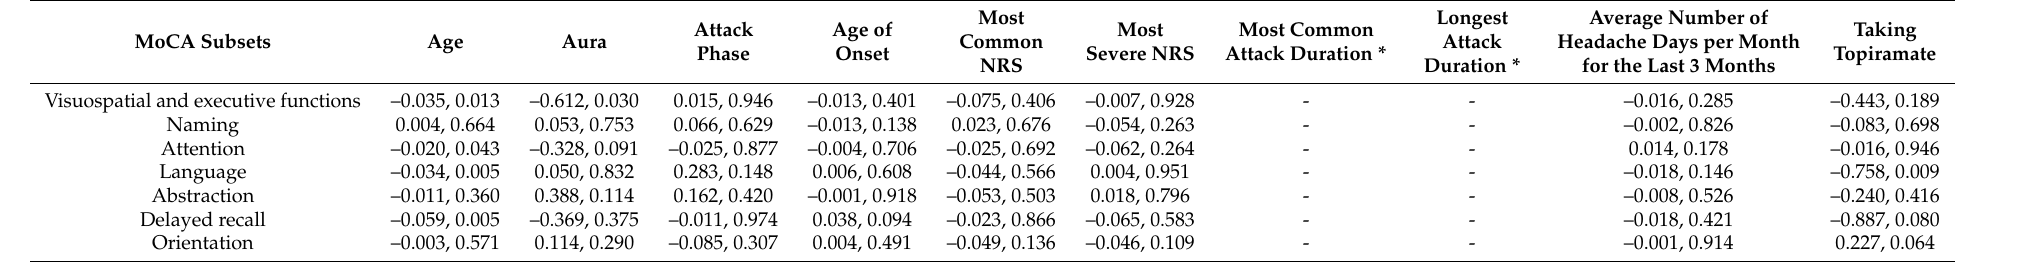
Table 9. Multiple linear regression of the factors influencing the MoCA subsets in migraineurs.